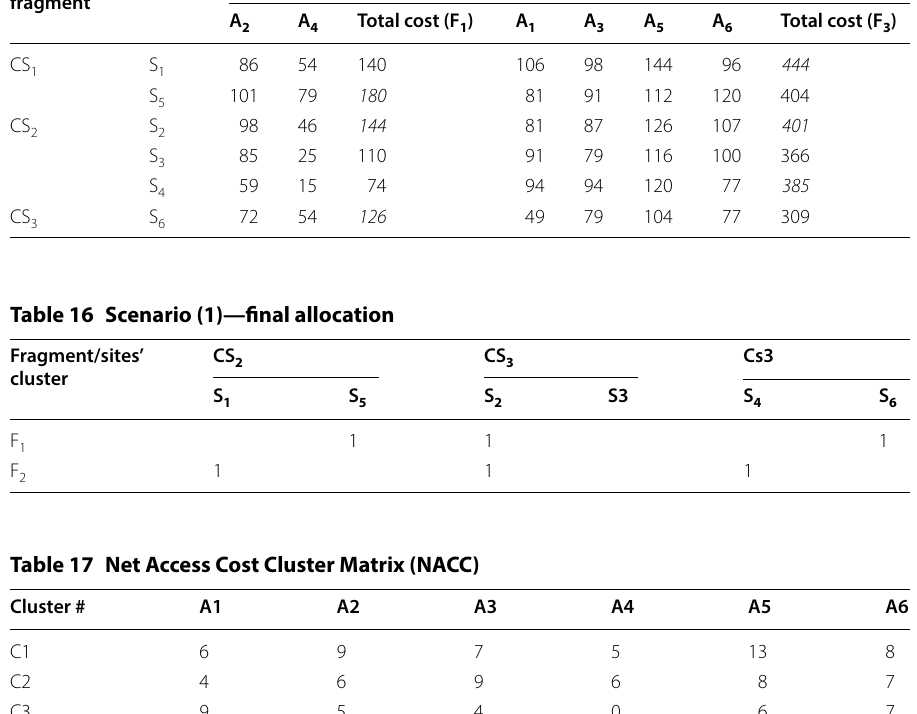
Table 15 Scenario (1)—Decision Allocation Matrix Sites’ cluster/ fragment